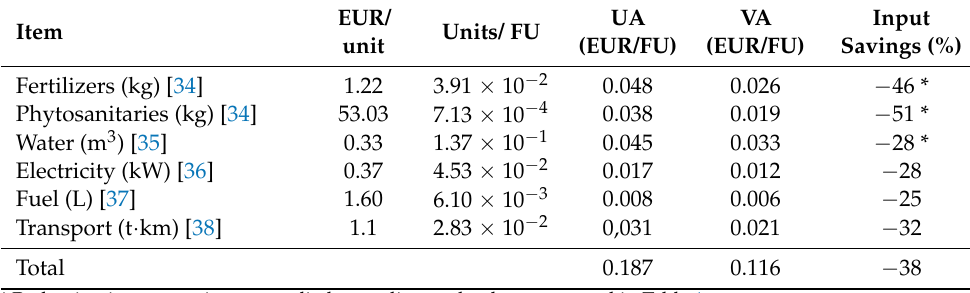
Table 3. Inputs cost summary of UA and VA scenarios (FU).